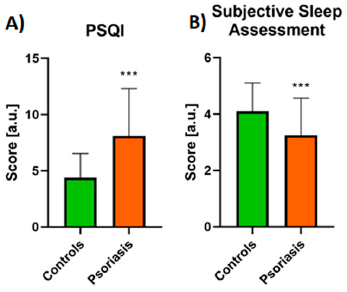
Table 3. Comparison between two subgroups: PASI (Psoriasis Area and Severity Index) I and PASI II in terms of baseline data, standard laboratory parameters, and values of sleep patterns.